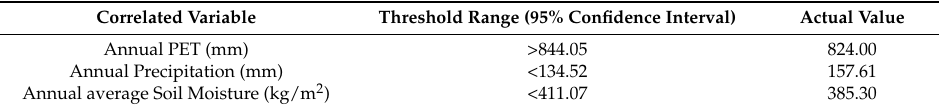
Table 6. The thresholds of the correlated variables to hydrological drought and actual